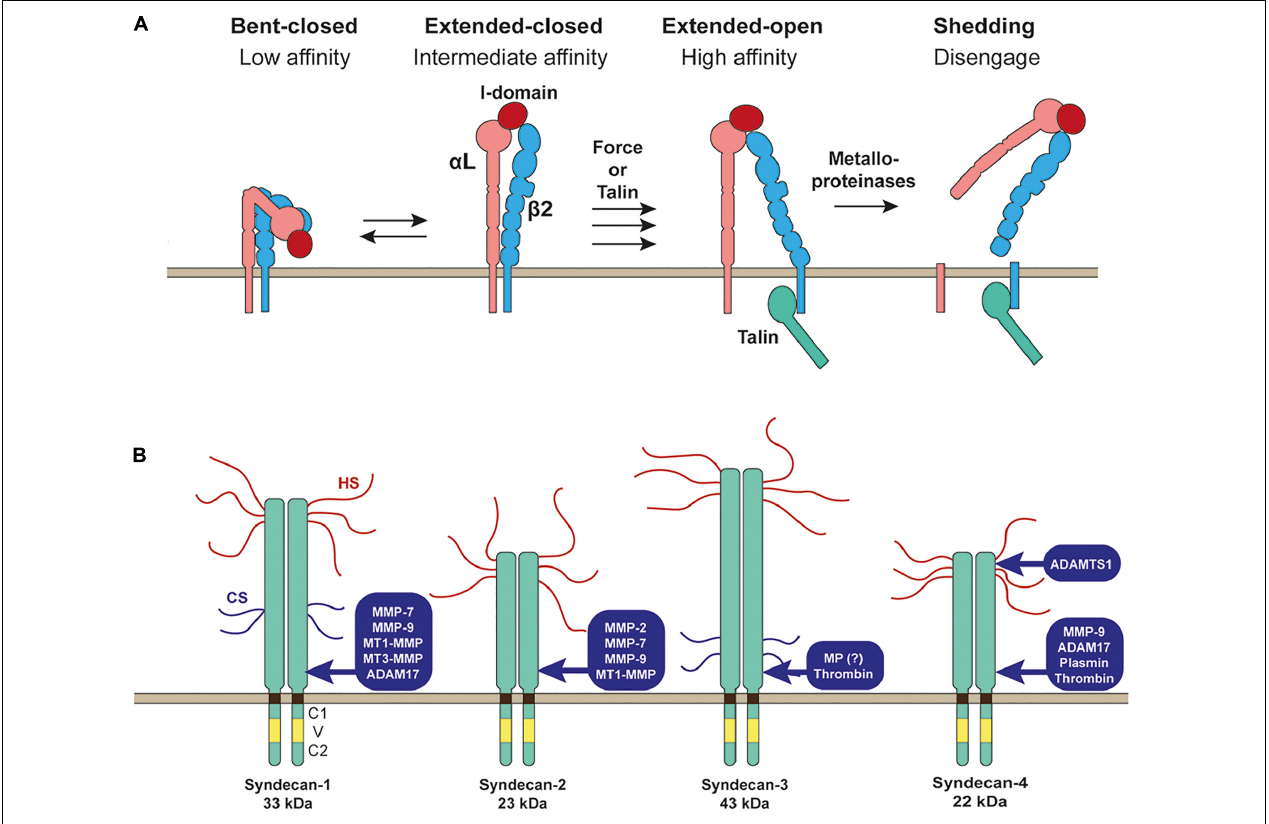
FIGURE 2 | Shedding of LFA-1 ( α L β 2 integrin) and syndecans. (A) Inactive bent-closed conformation of LFA-1 gets activated to extended-open conformation through external force or binding of talin at the cytoplasmic domain of β 2 integrin. LFA-1 is then cleaved by metalloporteinase(s) to release both α L and β 2 subunits to disengage LFA-1-mediated cell adhesion. (B) Proteinases reported to shed syndecans are